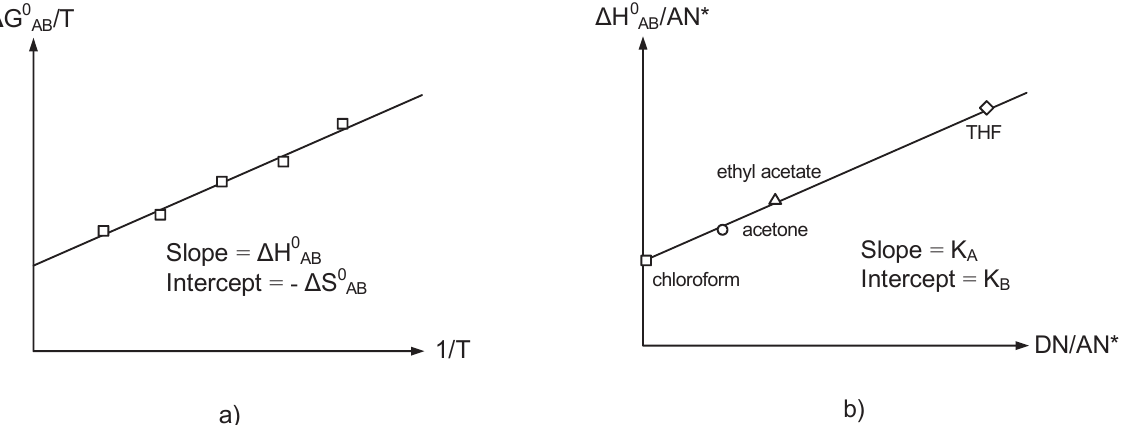
Fig. 4 Determination of a) acid-base enthalpy and entropy of adsorption from the acid/base free energy of adsorption via temperature variation, and b) the Gutmann ʼ s acid and base constants.